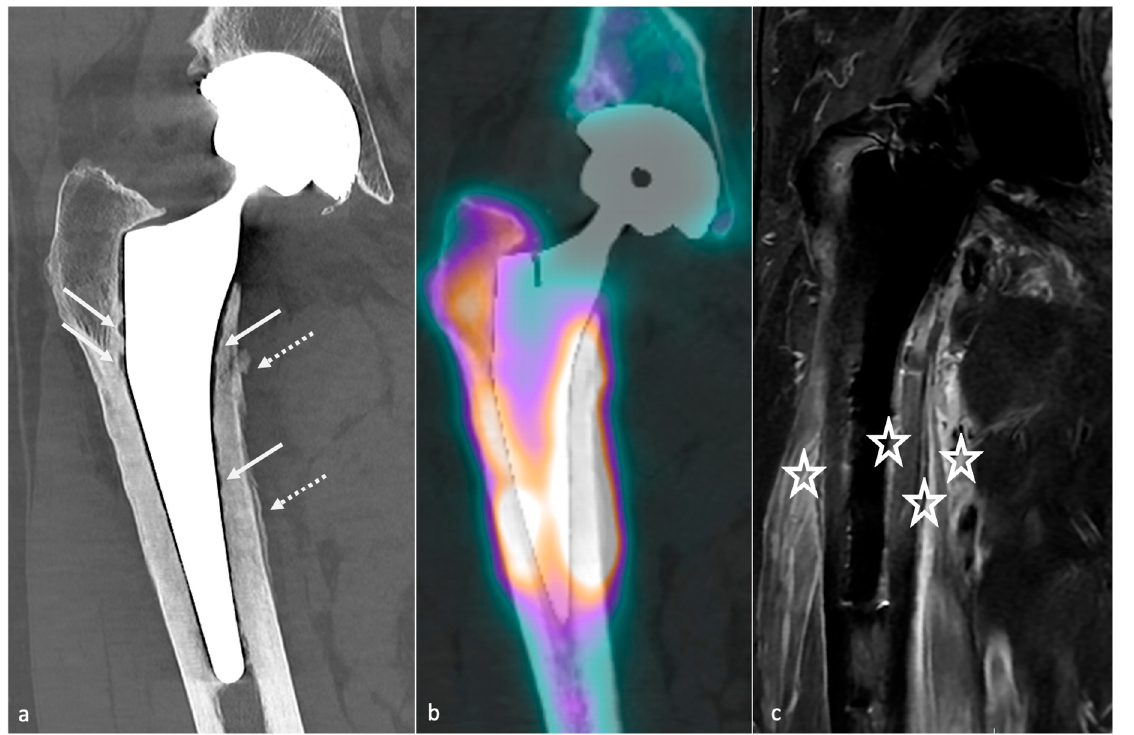
Figure 18. Infectious loosening (staphylococcus lugdunesis). An infectious loosening is shown on ( a ) a frontal CT-scan slice with irregular femoral endosteal osteolysis (white arrows) and periosteal reaction (dotted arrows), ( b ) a frontal SPECT-CT slice with diffuse hyperfixation, ( c ) a frontal T2 STIR image with a peri-prosthetic, cortical, and soft tissue hypersignal (white